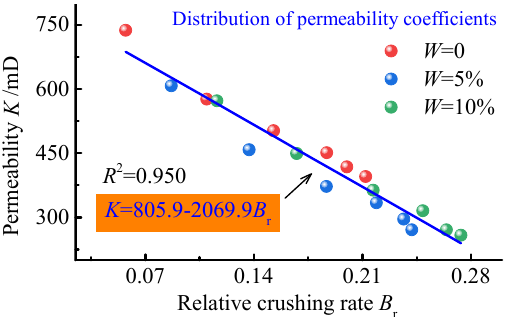
Figure 11. Effect of relative crushing rate on permeability.